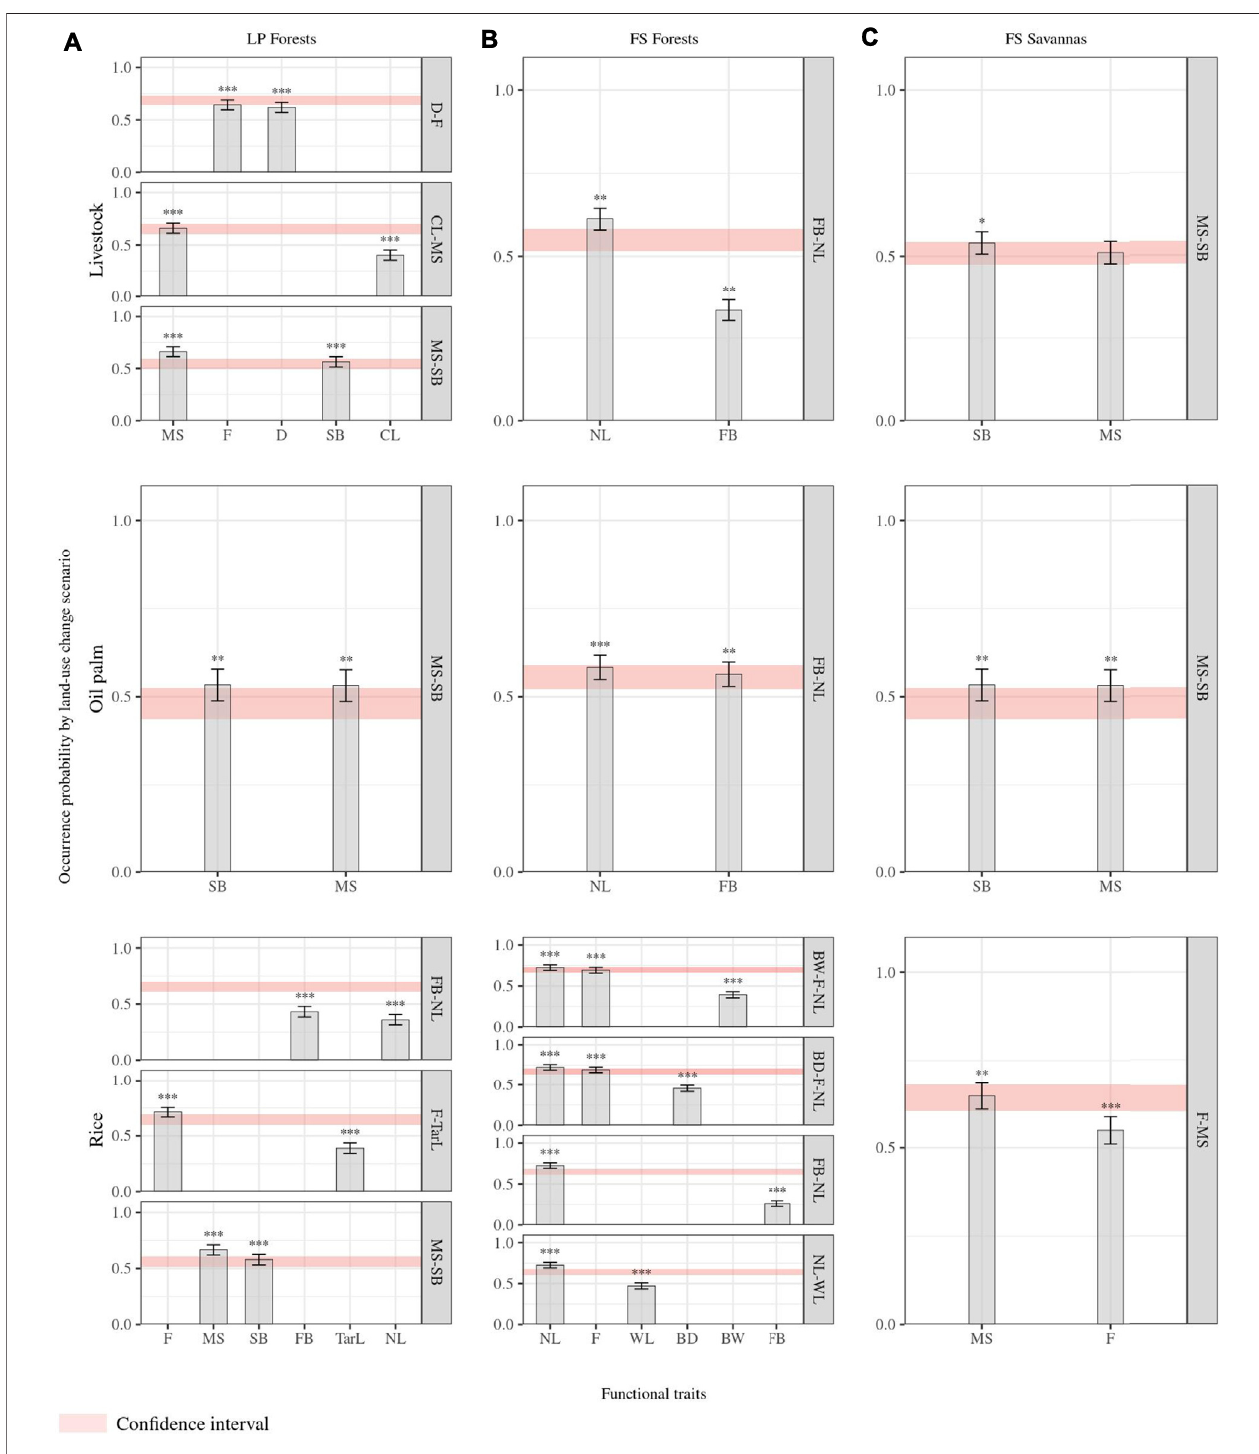
FIGURE3| Importanceofresponsefunctionaltraits.The y -axisrepresentstheprobabilityofin fl uenceofeachtraittopredictchangesinspeciesoccurrencedueto land-use changes. Con fi dence intervals represent the probabilities of the in fl uence of trait combinations of each trait to predict species occurrence changes. We calculated probability values from RF models with individual and combined traits. (A) . Land-use change scenarios from forests to agricultural covers in the Llanos piedmont(LP)landscape; (B) .land-usechangescenariosfromforeststoagriculturalcoversinthe fl oodedsavanna(FS)landscape; (C) .land-usechangescenarios fromnaturalsavannastoagriculturalcoversintheFSlandscape.Traits:BD:billdepthlengthatthebaselevel;BW:billwidthlengthatthebaselevel;WL:winglength;CL: culmen length; Tarl: tarsus length; SB: social behavior; D: diet; MS: migratory status; F: foraging stratum; FB: foraging behavior; NL: nest location. Asterisk brackets indicate signi fi cance values of traits estimated from the mean decrease accuracy metric (MDA) after fi ve thousand permutation null models for each combination trait by scenario. * p -value < 0.1, ** p -value < 0.05, *** p -value < 0.01.